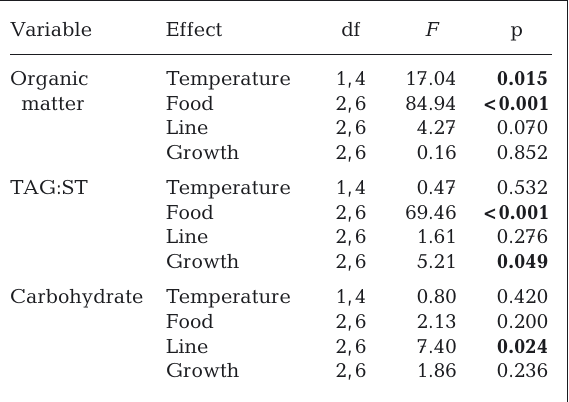
Table 4. Summary of ANOVAs. The tested effects were temperature (16.5 vs. 22°C), food level (starved, low and high), line (G0, G1 and G2) and growth rate (fast, medium, slow). Data of triacylglycerol:sterol ratios (TAG:ST) were log( x + 1) transformed. Significant p-values (p < 0.05) are in bold